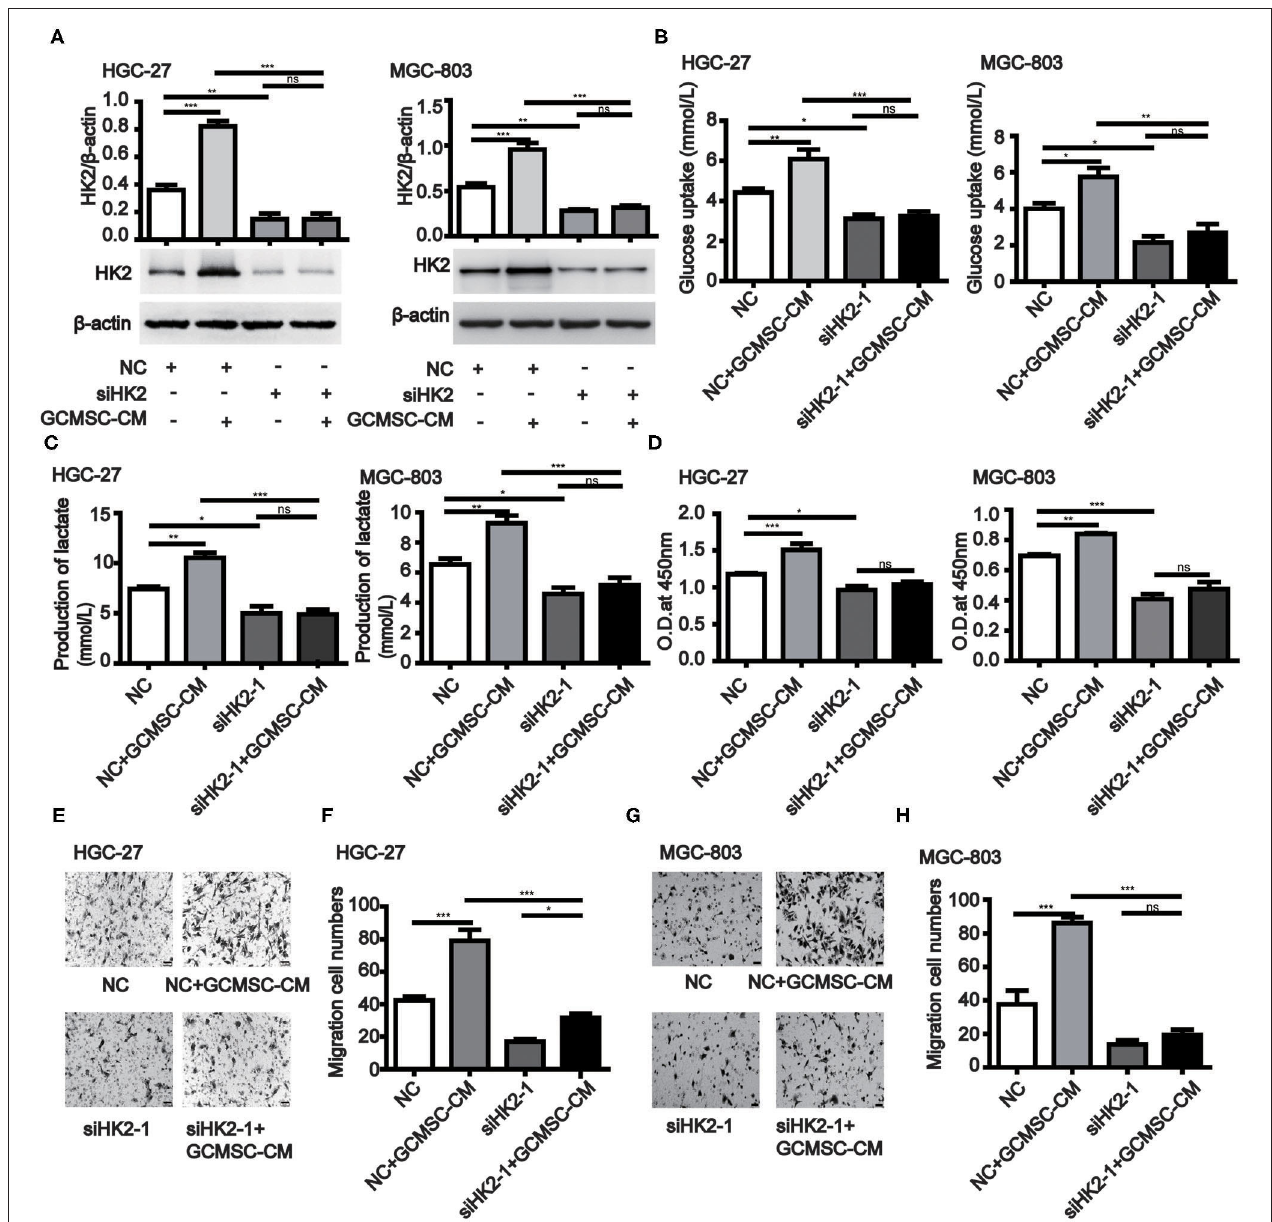
FIGURE 2 | GCMSCs facilitate glucose metabolism, proliferation, and migration of gastric cancer cells by regulating HK2. (A) Immunoblotting of the HK2 expression in HGC-27 and MGC-803 cells treated with the indicated reagent following transfection with siHK2-1 or NC (down). Quantitative statistics of the HK2 expression in different groups (up). (B) Glucose uptake in HGC-27 and MGC-803 cells treated with the indicated reagent following transfection with siHK2-1 or NC. (C) Lactate production in HGC-27 and MGC-803 cells treated with the indicated reagent following transfection with siHK2-1 or NC. (D) Proliferation of HGC-27 and MGC-803 cells treated with the indicated reagent following transfection with siHK2-1 or NC detected by CCK-8. (E) Migration of HGC-27 cells treated with the indicated reagent following transfection with siHK2-1 or NC detected using the Transwell assay. (F) Quantitative statistics of the HGC-27 cell migration in different groups. (G) Migration of MGC-803 cells treated with the indicated reagent following transfection with siHK2-1 or NC detected using the Transwell assay. (H) Quantitative statistics of the MGC-803 cell migration in different groups. ( n = 3; * P < 0.05; ** P < 0.01; *** P <